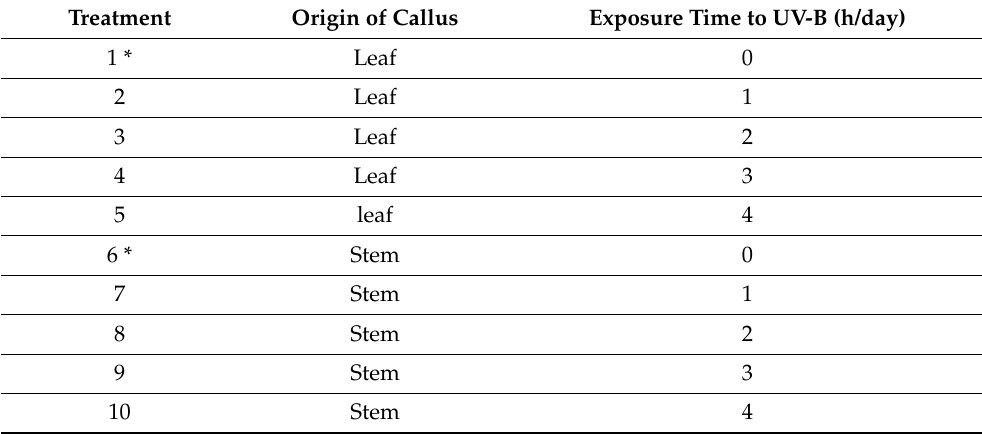
Table 7. Experimental design to evaluate the explant of origin of the callus and the exposure time to UV-B radiation on morphology, growth parameters and secondary metabolites. Treatment Origin of Callus Exposure Time to UV-B